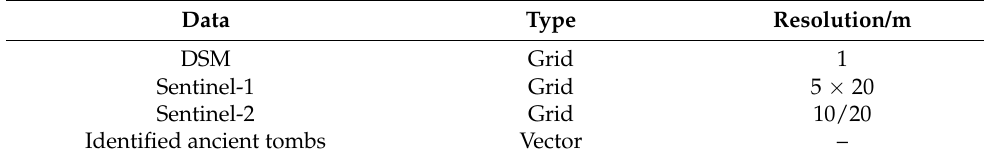
Table 1. Basic properties of research data.